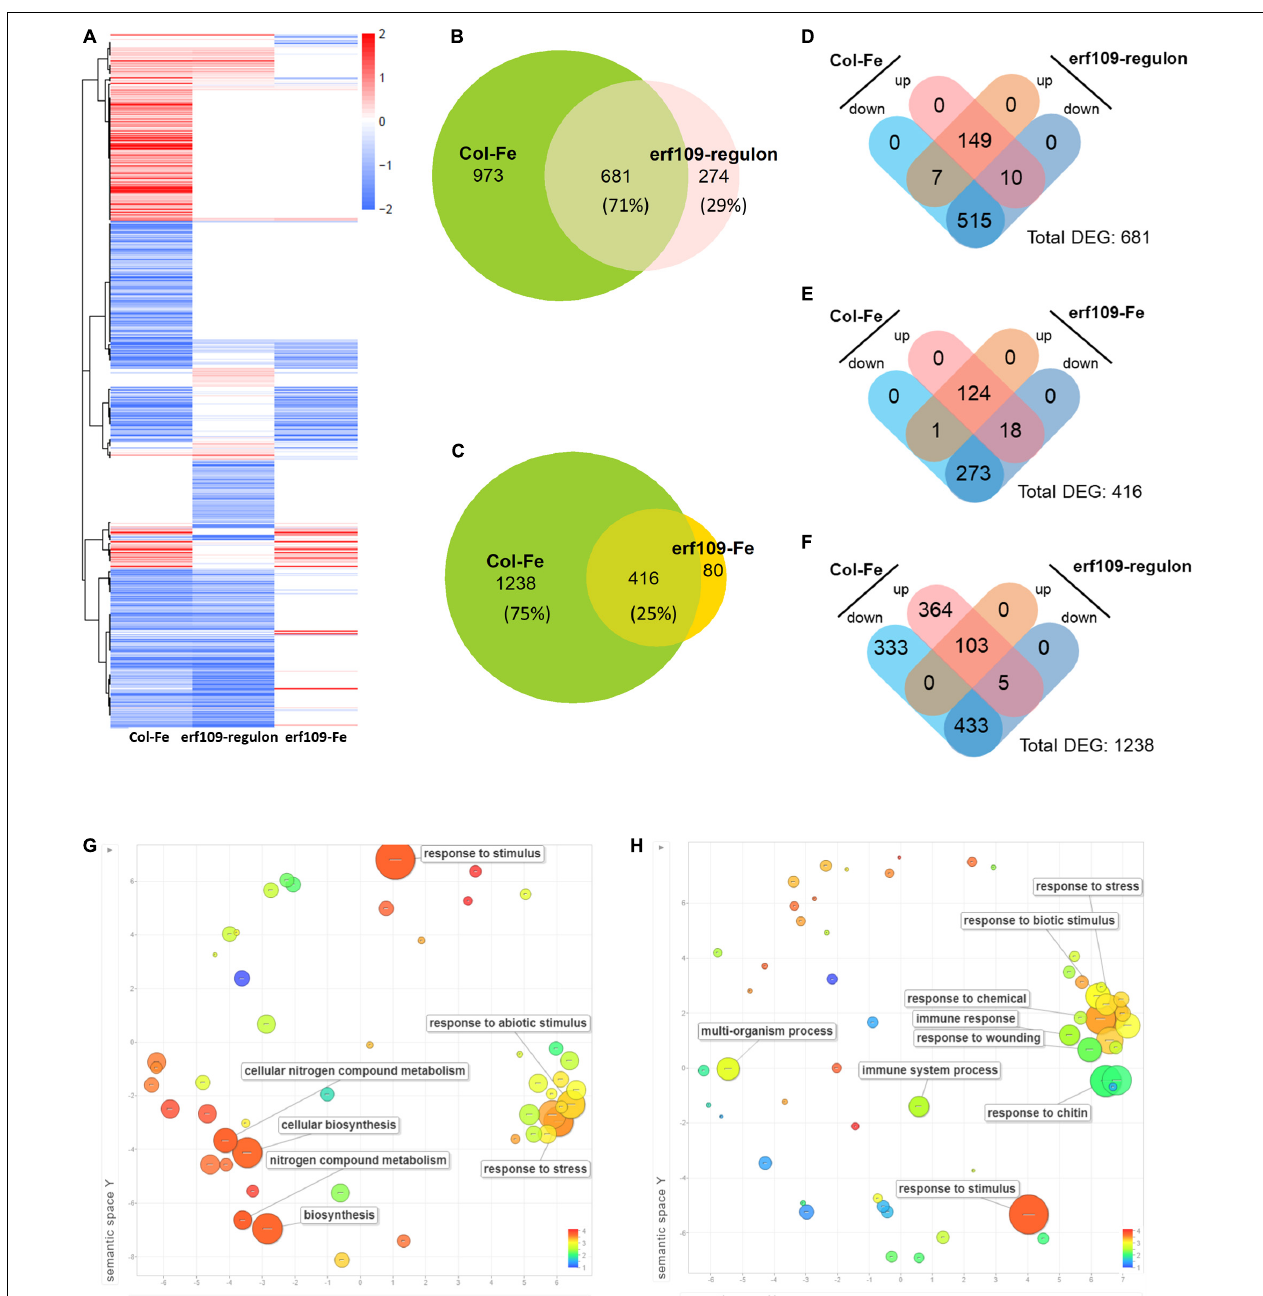
FIGURE 2 | Differentially expressed transcripts, expression profiles and gene ontologies of Col-Fe, the erf109 -regulon and erf109 -Fe. (A) Heatmap of three transcriptomic profiles. Red and blue color indicates up- and down-regulated expression of DEGs with log2-fold change, respectively. (B) Venn diagram of DEGs from Col-Fe and the erf109 -regulon. (C) Venn diagram of DEGs from Col-Fe and erf109 -Fe. Distribution of up- and down-regulated DEGs overlapping between Col-Fe and the erf109 -regulon (D) , overlapping between Col-Fe and erf109 -Fe (E) , and erf109 -regulon DEGs in specific of 1,238 Col-Fe DEGs (F) . GO analysis (biological process) of 149 up- (G) and 515 down-regulated DEGs (H) overlapping in the Col-Fe and erf109 -regulon data sets. Dot size indicates –log10 ( P- value), the log value is labeled with the color bar from 1 to 4.